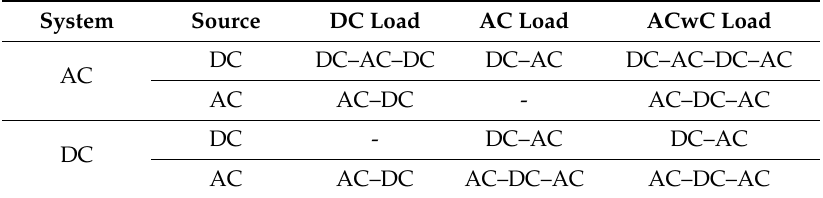
Table 2. Power conversion roadmap for AC and DC power systems [23].